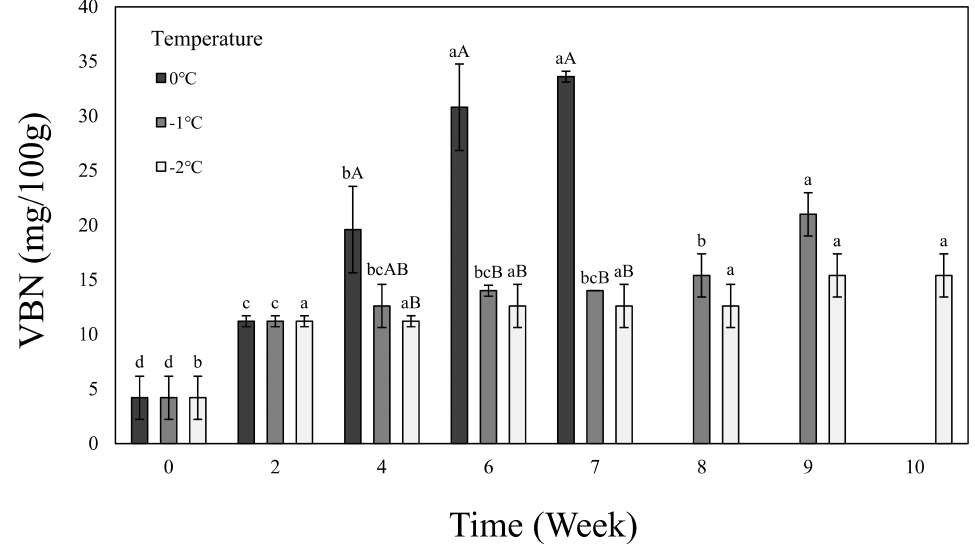
Figure 3. VBN of dry-aged beef loin on 0, − 1, − 2 ◦ C temperature electric field refrigerate sys- tem. a–d Means in the same temperature with different letters are significantly different ( p < 0.05). A, B Means in the same time with different letters are significantly different ( p < 0.05). Samples were measured until aging stopped as the value of TPC reached 7 log